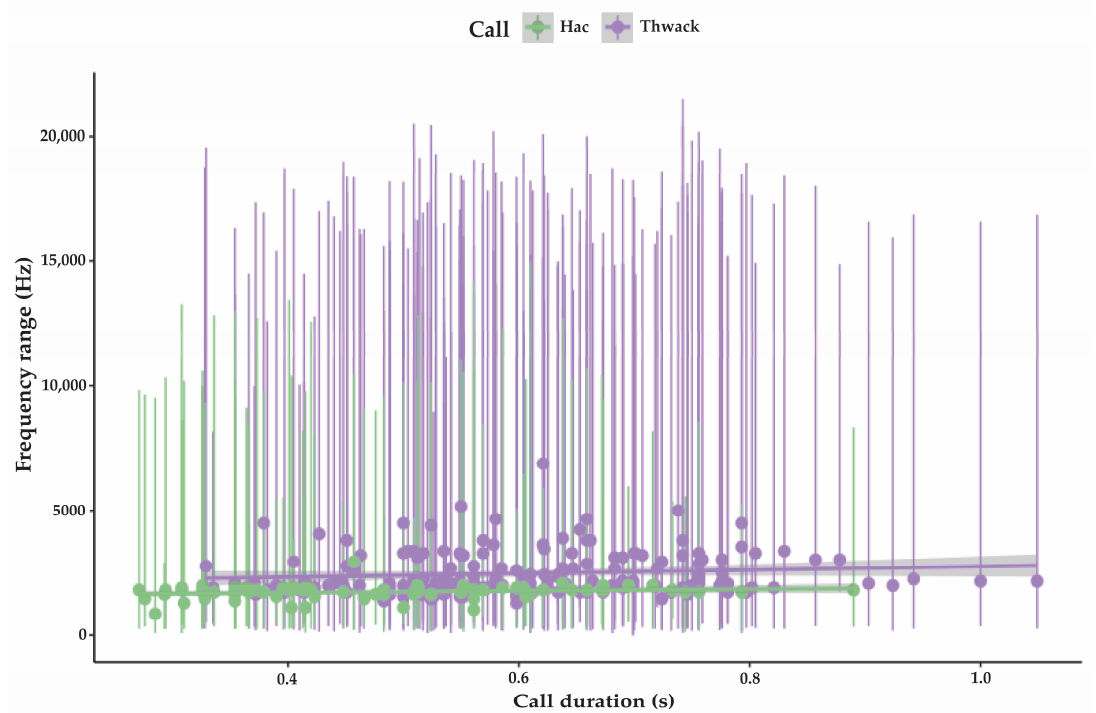
Figure 4. Variants of Dendrohyrax strangled thwack ( A , B ) and hac ( C , D ) calls (upper images: waveform, lower images: spectrogram). ( A ) Strangled thwack with embedded wheeze element (Sound S7). ( B ) Double strangled thwack (Sound S8). This call type was frequently recorded in one area of Ngangao Forest and was probably used by the same Dendrohyrax individual. ( C ) Double hac with thwack-like second unit (Sound S9). ( D ) Hac call with four subunits (Sound S10). The number of subunits in hac calls varies from one to four.